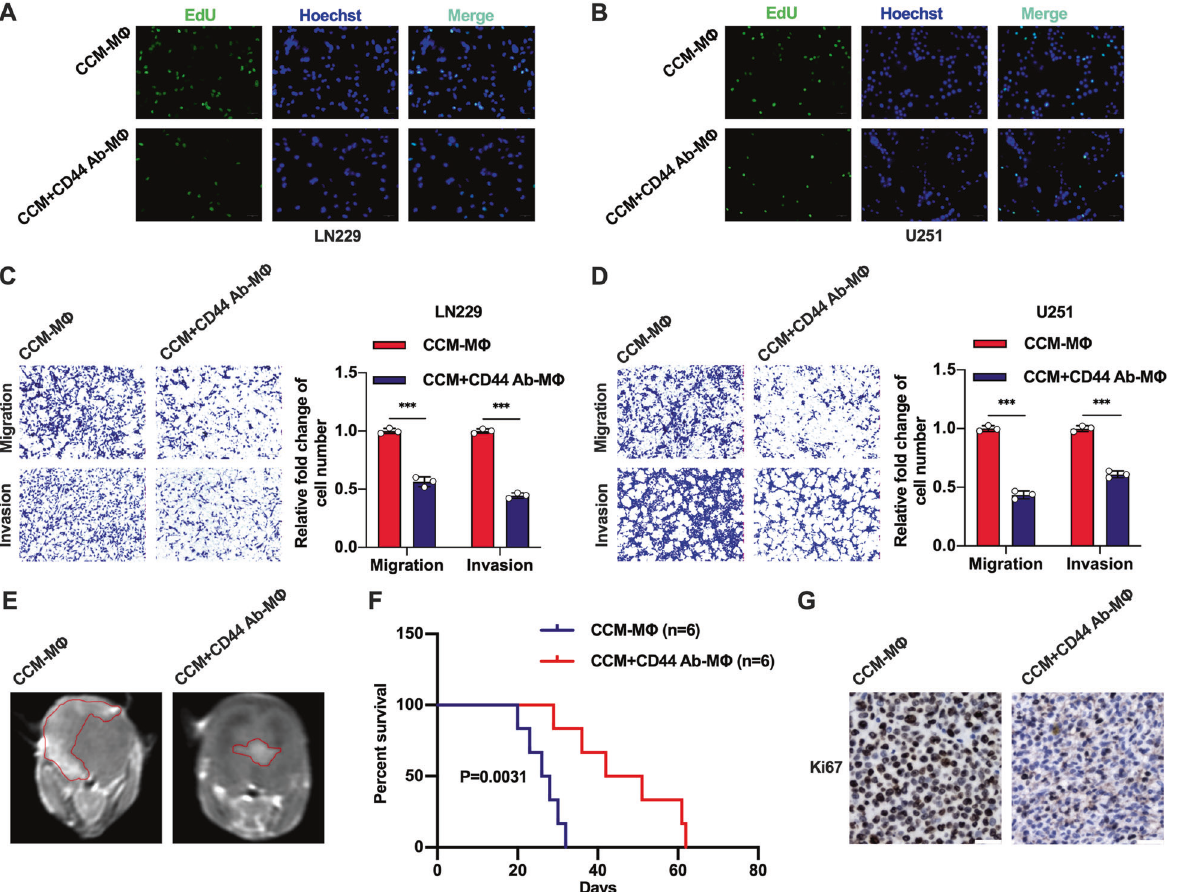
Fig. 4 Macrophages induced by anti-CD44 antibody and CCM inhibit glioblastoma cell proliferation and motility in vitro and in vivo. A – D Macrophages pretreated with the anti-CD44 antibody (6 μ g/ml) were cultured with CCM for 48 h. Then, induced macrophages were subsequently cocultured with U251 or LN229 glioblastoma cells for 48 h. An EdU assay was performed to test the glioblastoma cells proliferation (bar: 50 μ m). Transwell assays were used to analyze the glioblastoma cells migration and invasion abilities. (bar: 100 µm) E , F Representative MRI scans and survival curves of xenograft tumors from mice co-implanted with glioblastoma cells and macrophages. Two xenograft model groups were established, as follows: (1) glioblastoma cells and CCM-derived macrophages (Median survival time: 27 days), (2) glioblastoma cells and CCM-derived macrophages pretreated with anti-CD44 antibody (Median survival time: 46.5 days). G Representative images of Ki67 IHC staining in xenograft tumor tissues are described in Fig. 4E (bar: 30 μ m). Error bars show mean ± SD. * P < 0.05, ** P < 0.01, and *** P <